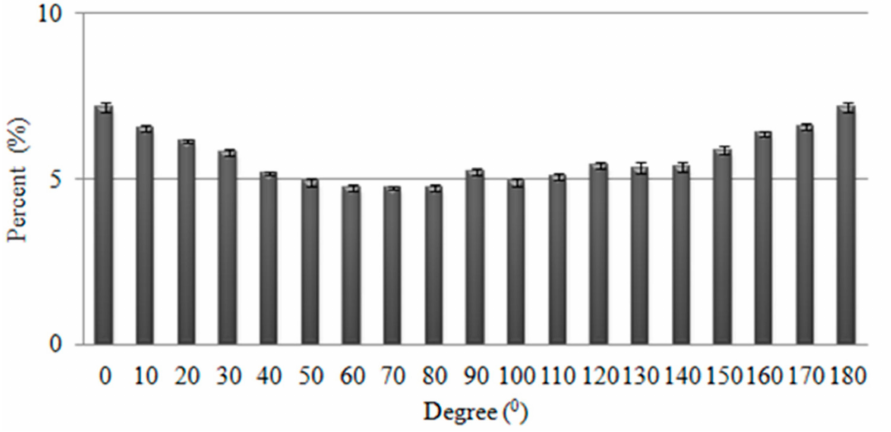
Figure 5. Fiber angle distribution (0–180 degree) of PT nonwoven